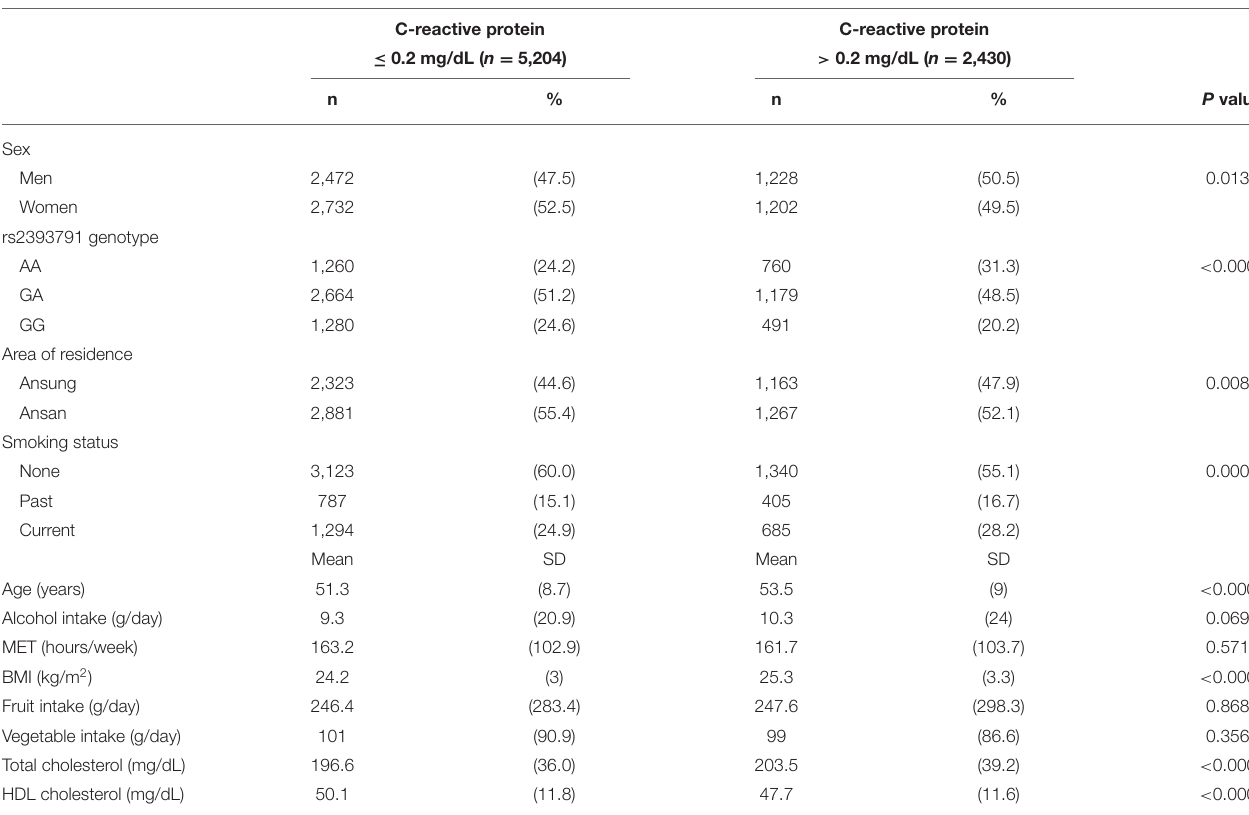
TABLE 1 | Characteristics of study participants in accordance with their C-reactive protein levels. C-reactive